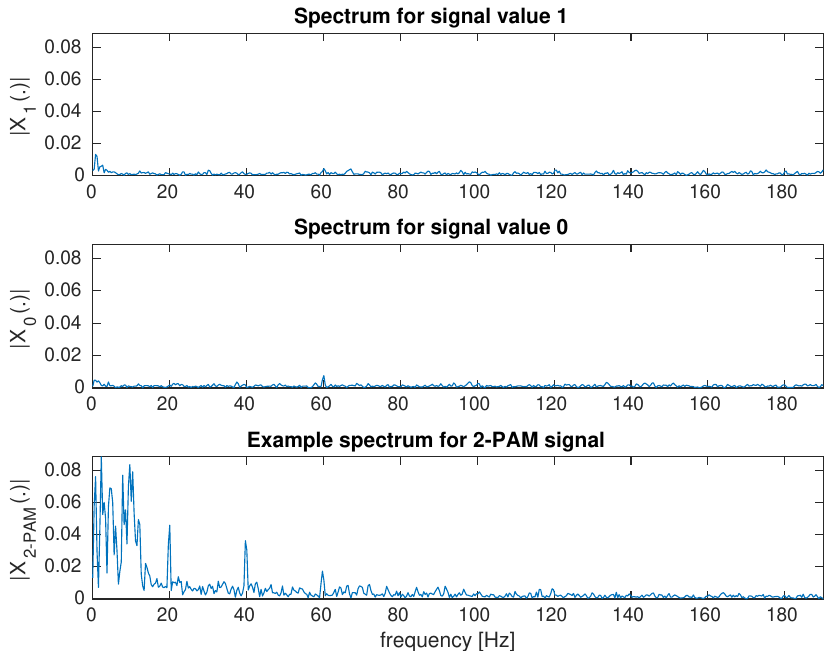
Figure 15. Signal spectra for the average brightness of the frames of the video sequence. Spectra for two brightness levels and a random transmitted sequence with 2–PAM modulation are shown. Brightness modulation with LCD backlight.